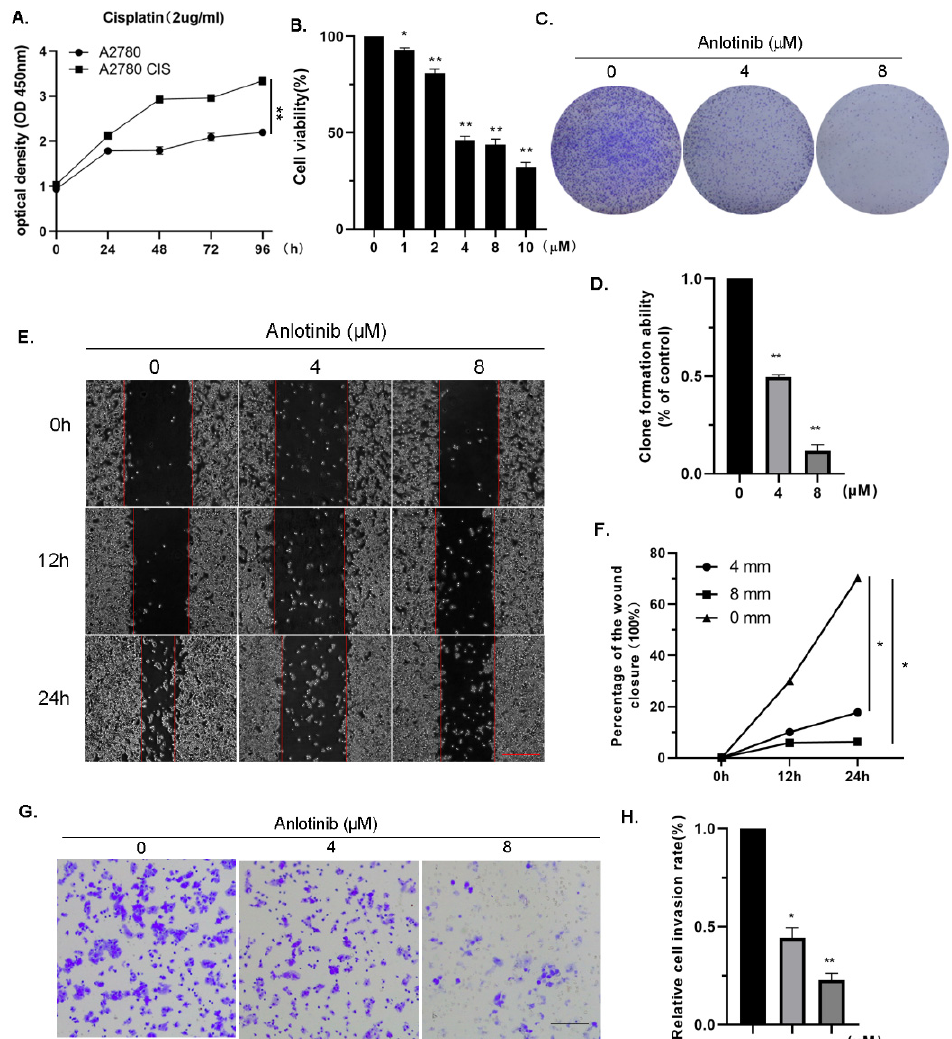
Figure 2. Anlotinib inhibits the proliferation, migration, and invasion of cisplatin-resistant ovarian cancer cells in vitro. ( A ) A2780 and cisplatin-resistant cell line A2780 CIS were treated with cisplatin. Cell viability was measured by CCK-8. ( B ) A2780 CIS cells were treated with different concentrations (0, 1, 2, 4, 8, and 10 µ M) of anlotinib for 72 h. Cell viability was measured by CCK8. ( C , D ) Representative images of colony-formation assay. ( E – G ) The effects of anlotinib on cell invasion and migration were measured using wound-healing ( E , F ) and transwell assays ( G , H ). All experiments were performed in at least three biological replicates, and each biological replicate contained three technical replicates. Student’s t -test was used to compare values between control and different treatment groups. * p < 0.05, ** p < 0.01 vs. control group. OD, optical density. Scale bars = 100 µ m.